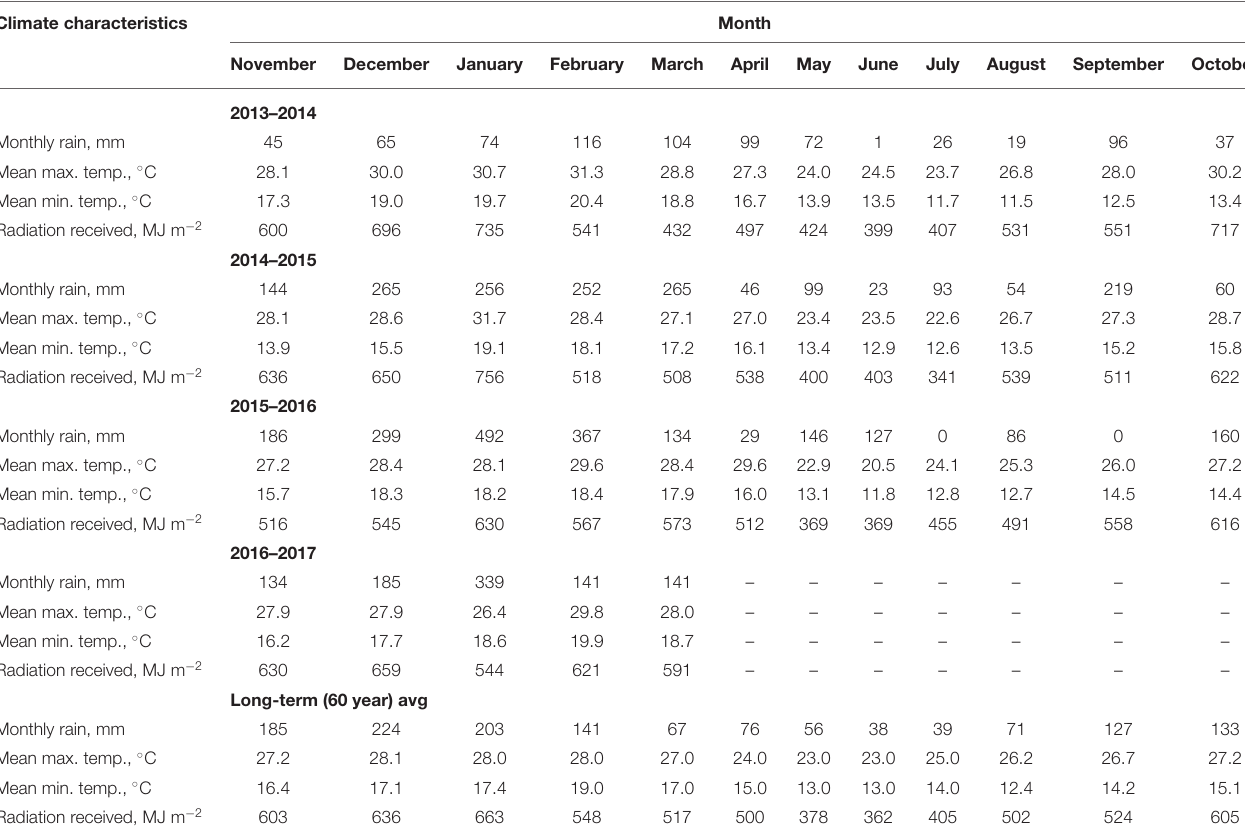
TABLE 1 | Rainfall, maximum and minimum temperatures, and radiation received at Botucatu, São Paulo, Brazil, during the study period and long-term averages. Climate